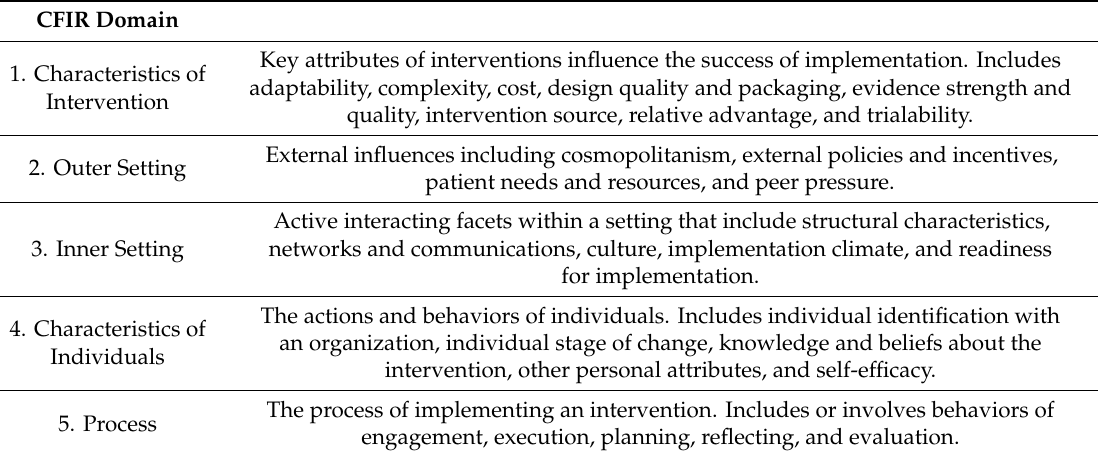
Table 2. Consolidated Framework for Implementation Research (CFIR) Domain